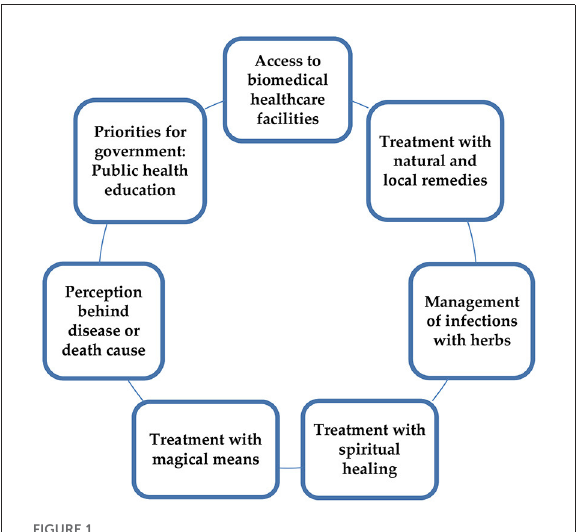
FIGURE1 Disease etiologies and treatment practices among rural mothers in Southern